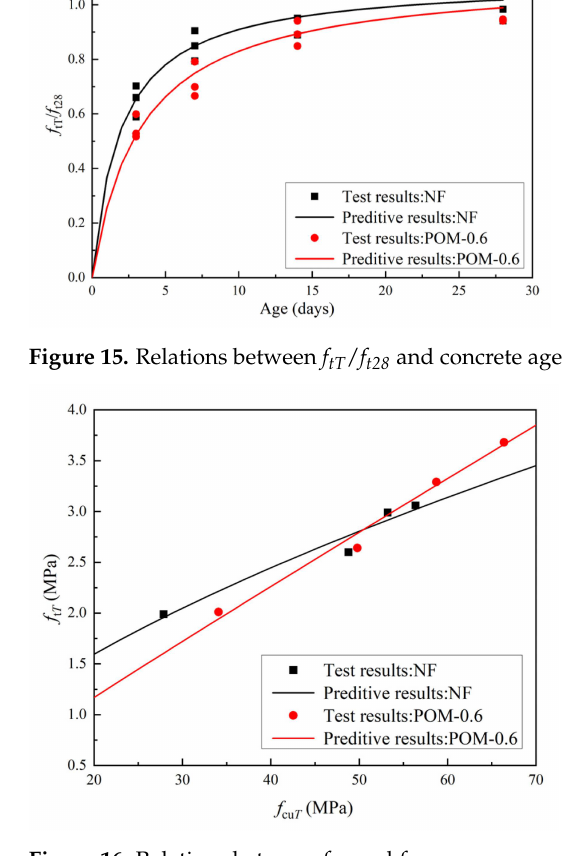
Figure 16. Relations between f t T and f cu T .